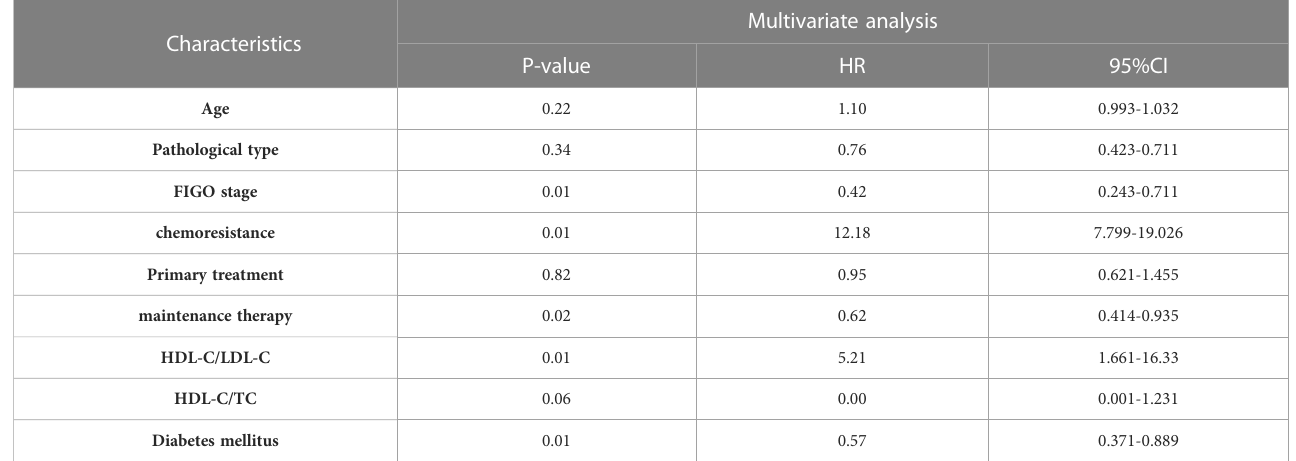
TABLE 3 Multivariate survival analysis of FPS in 249 patients with ovarian cancer.